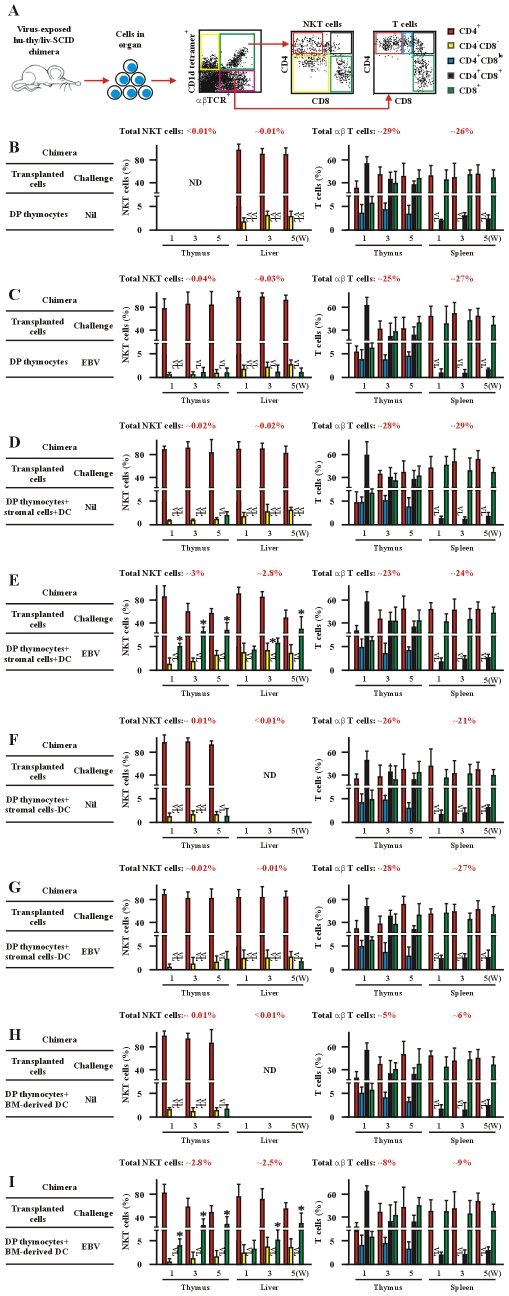
EBV-induced CD8+ NKT cell development occurs at the DP thymocyte stage and depends upon thymic dendritic cells.(A) The experimental and analysis scheme for detecting co-receptor-expressing NKT cells and T cells in various organs from different hu-thy/liv-SCID chimeras is illustrated after collecting 2.0×106 total cell events. (B–I) Development of co-receptor-expressing NKT cells (middle panels) and T cells (right panels). Data illustrate the frequency of co-receptor-expressing NKT cells and T cells in thymus, liver and spleen from EBV-challenged hu-thy/liv-SCID chimeras (EBV). Unchallenged hu-thy/liv-SCID chimeras (Nil) were used as controls. The protocols for the establishment of the various hu-thy/liv-SCID chimeras were described in the leftmost panels. (B–G) Instead of total thymocytes, hu-thy/liv-SCID chimeras were established by intrathymic transplantation with DP thymocytes. The chimeras were sacrificed at the indicated time points following post-immune-reconstitution and viral challenge. Staining was performed as in Figure 2. +DC, thymic DCs were included. -DC, thymic DCs were depleted. In (H) and (I) the hu-thy/liv-SCID chimeras were established by intrathymic transplantation with DP thymocytes. Instead of transplantation with thymic stromal cells, BM-derived dendritic cells (1×106 cells) were injected i.v. into the hu-thy/liv-SCID chimeras at t = 0. VL, very low level (below detectable level). ND, no determination. Data (B–I) were mean ± s.d. (n  =  8). *, p<0.001, EBV-challenged chimeras vs. non-challenged chimeras.